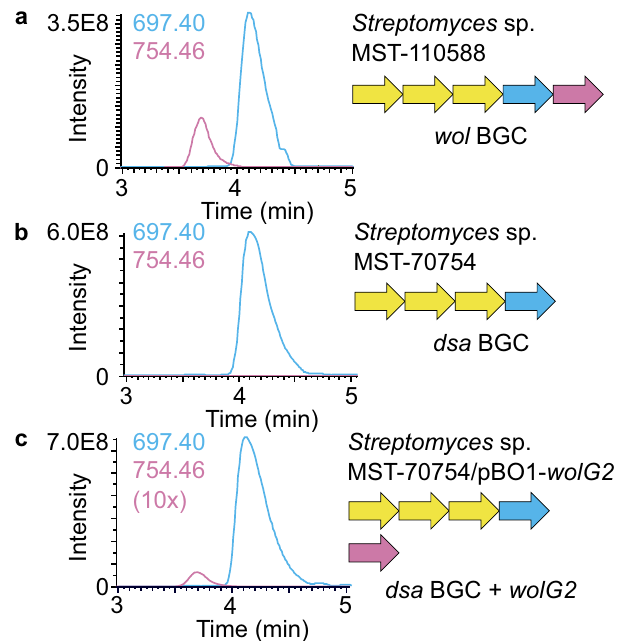
Fig. 3 Heterologous production of the wollamides by overexpression of wolG2. a The extracted ion chromatograms (EIC) for masses corresponding to desotamide A ([M + H] = 697.40) and wollamide A ([M + H] = 754.46) from wild-type Streptomyces sp. MST-110588 producing both compounds. b The EICs of desotamide A and wollamide A from Streptomyces sp. MST-70754 producing desotamide A only. c The EICs of desotamide A and wollamide A from Streptomyces sp. MST-70754/ pBO1-wolG2 producing both compounds. Schematic representations of the assembly lines and overexpressed genes are also shown. (dsa desotamide, wol